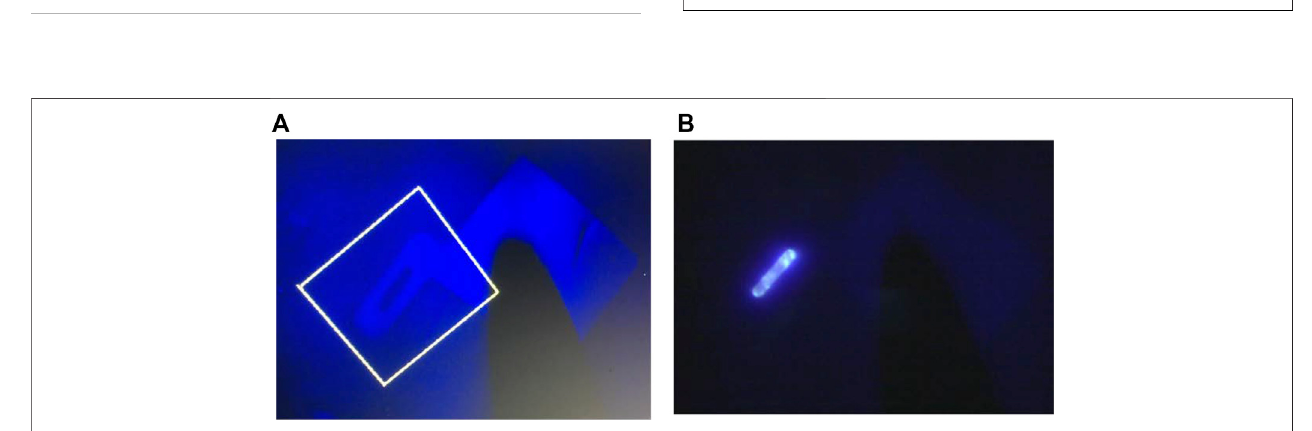
FIGURE 6 | (A) The optical microscope image of the APD layout. The APD edges were covered by metal, leaving a rectangular via to detect optical signals. (B) the image of the APD when the avalanche occurred, the light was emitted from the device.